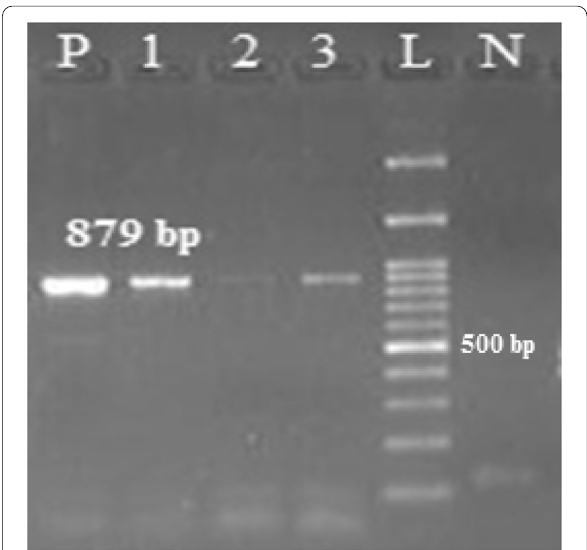
Fig. 2 PCR product electrophoresis of invC gene. Lane L is related to DNA marker: 100 bp ( SMO321 , Fermantas ); Lane P: positive control; Lane 1–3: positive samples; Lane N: negative